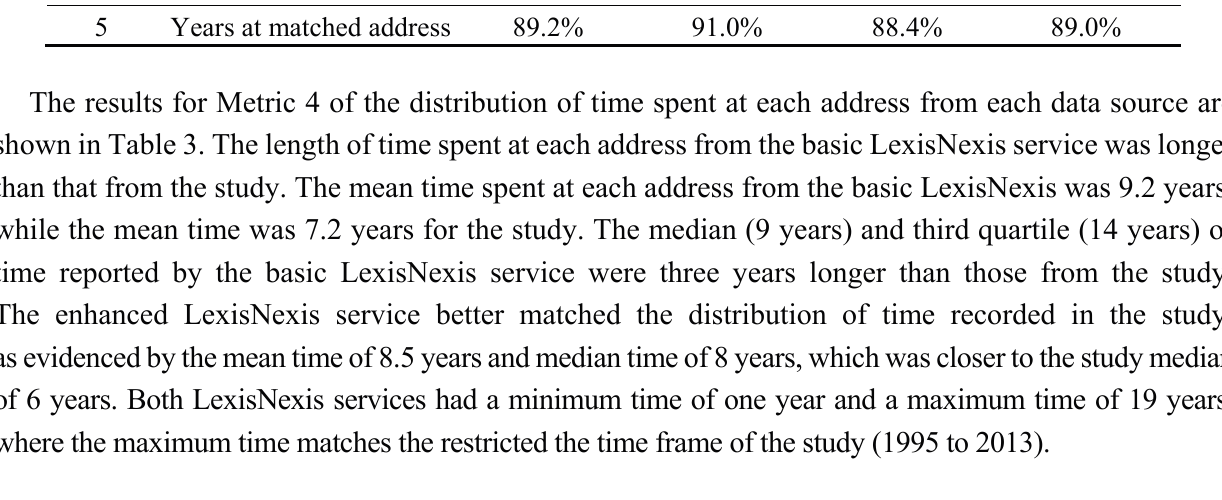
Table 3. Results for Metric 4 of distribution of time spent in years at each address from each data